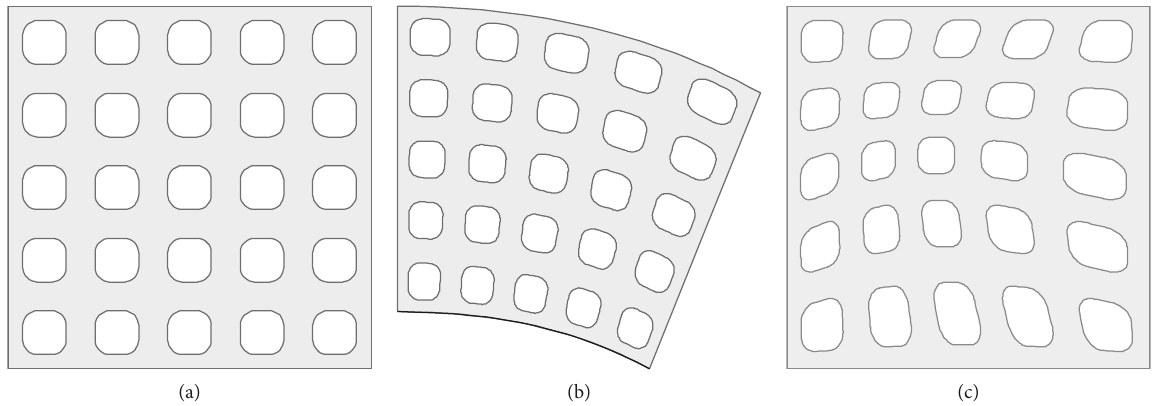
Figure 2: Exempli fi cation of a (a) regular, (b) conformal (the structure is bended on the thick curve), and (c) warped cellular materials.